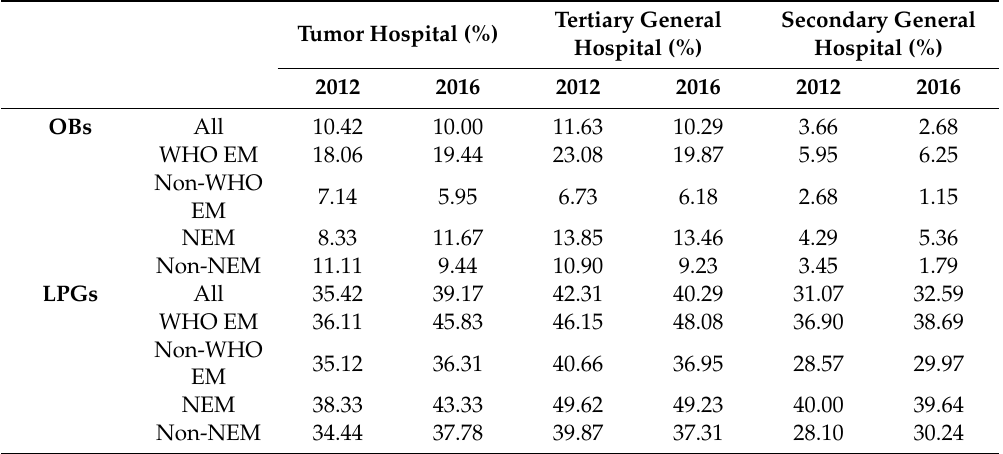
Table 4. Mean availability of anticancer medicines in the Jiangsu Province: inter-sector comparison.